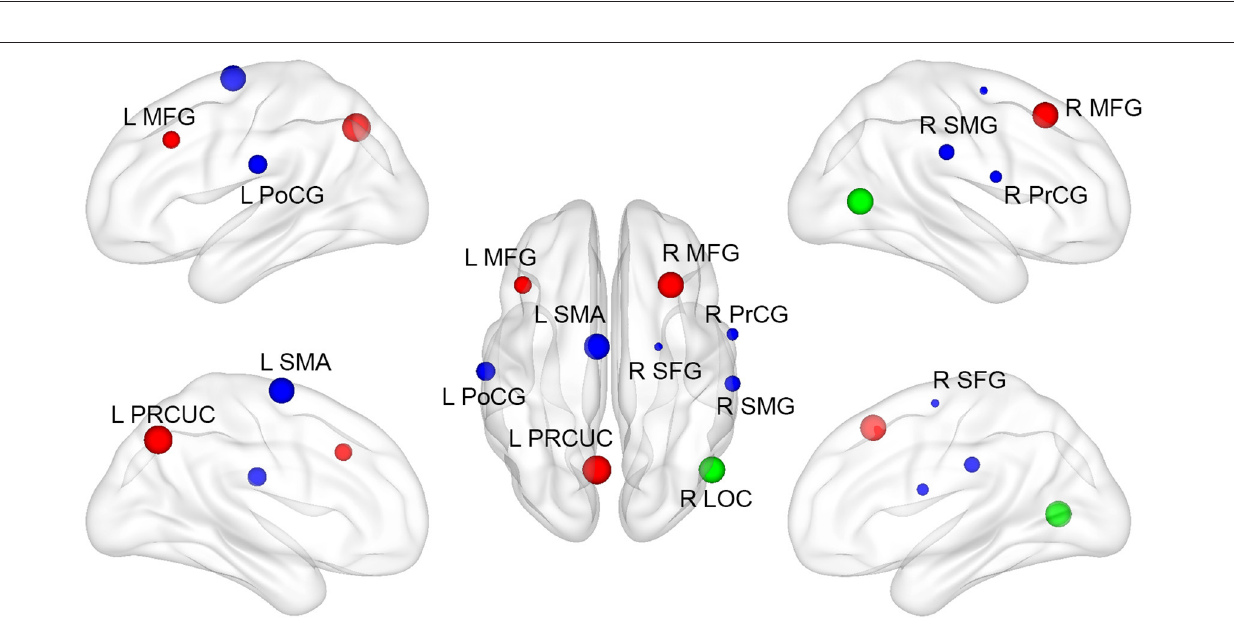
FIGURE 4 | Regions with significantly different ROI-based functional connectivity in right-sided stroke patients. Compared to HCs, the location and cluster size of regions with significantly different R LOC-based functional connectivity. Red and blue nodes represent those regions of which functional connections were greater and less than HCs, respectively. The green node represents the seed ROI (R